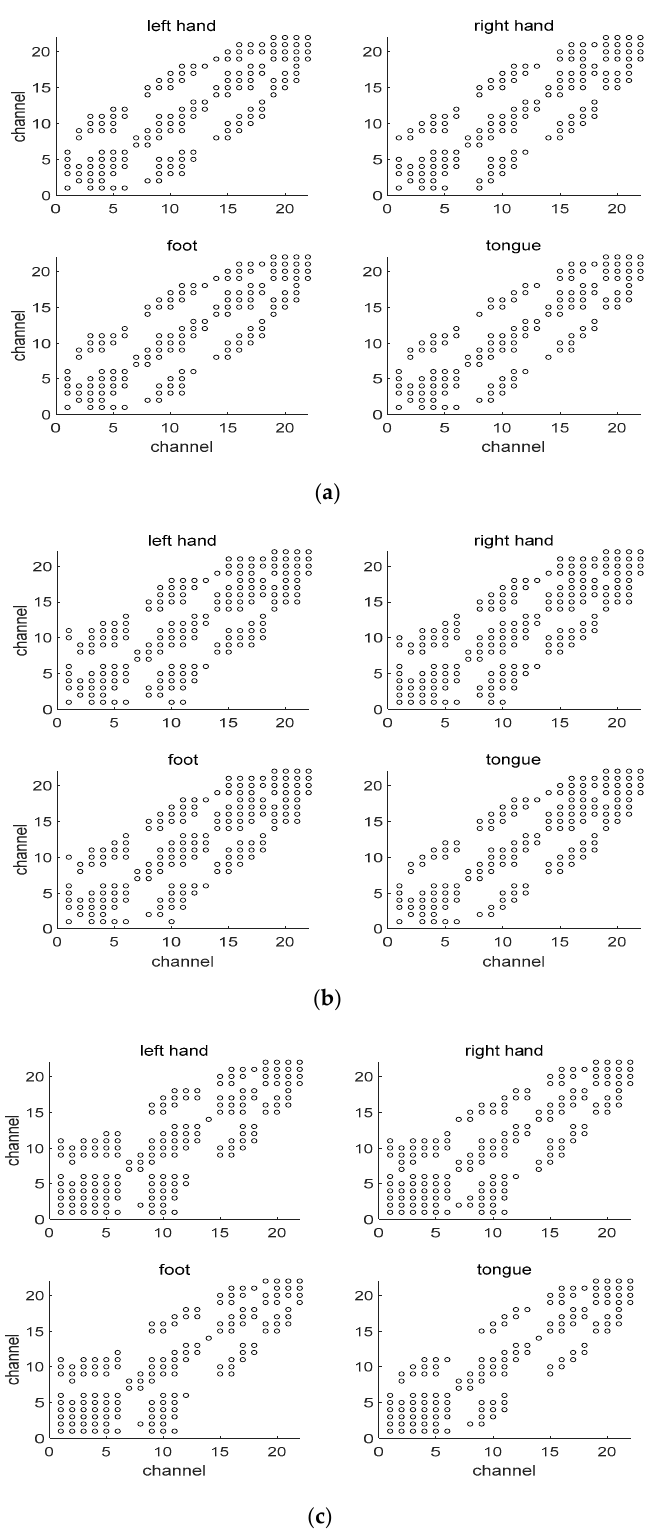
Figure 4. Correlation between channels for each MI. The circle (o) represents a high correlation between two channels. ( a ) Subject 1; ( b ) Subject 3; ( c ) Subject 8.